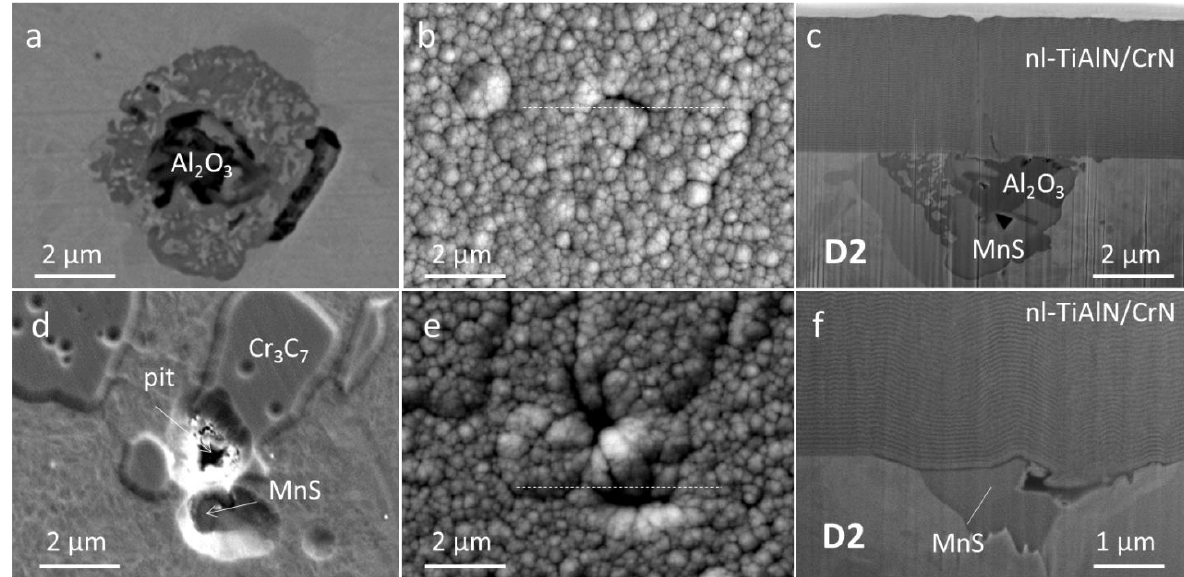
Figure 11. Plain-view SEM images of the same surface area at the site of a complex multicomponent non-metallic inclusion in a D2 tool steel substrate after MF ion etching ( a ), deposition of the NL-TiAlN/CrN coating ( b ) and FIB cross-sections of the coating ( c ). Similar SEM images were taken at the site of a MnS inclusion in the D2 tool steel substrate after MF and booster ion etching ( d ), deposition of the NL-TiAlN/CrN coating ( e ) and FIB cross-sections of the coating ( f ).